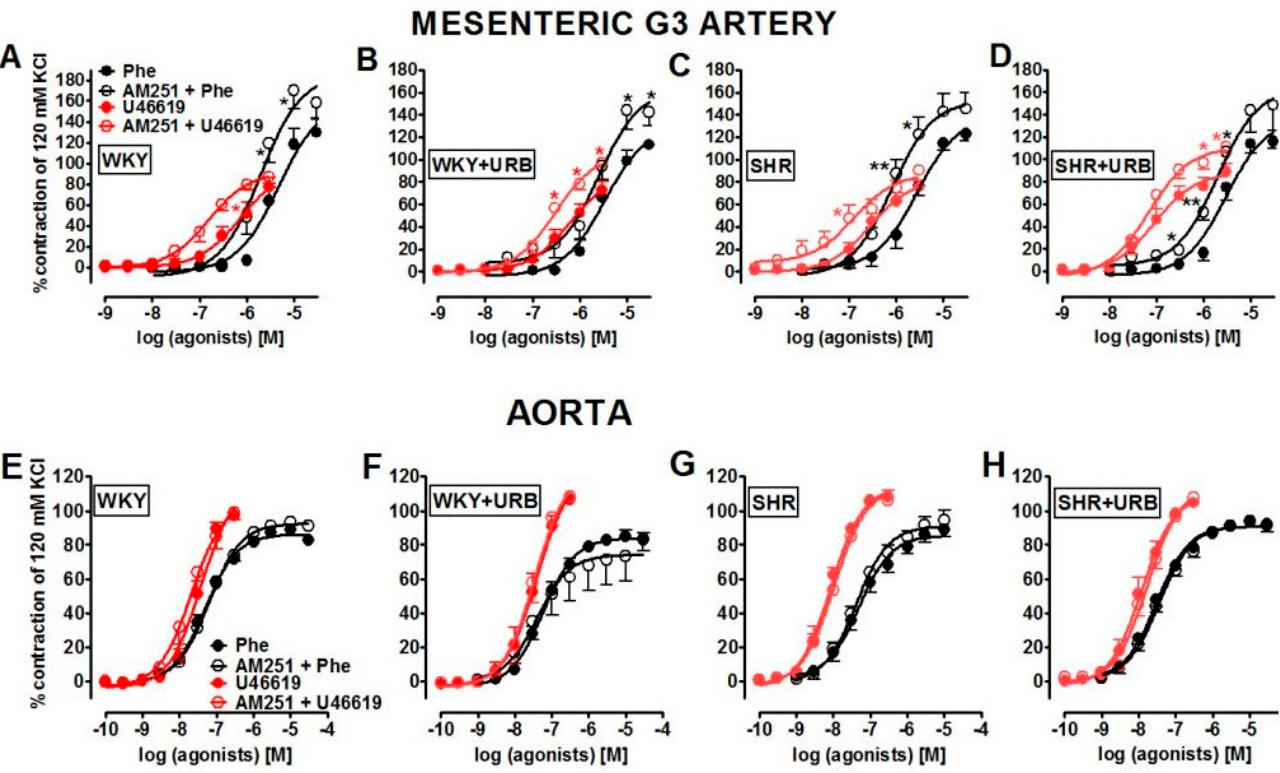
Figure 2. Influence of AM251 (1 µ M) on the vasoconstrictive effects of phenylephrine (Phe, black circles) and U46619 (red circles) in the mesenteric G3 arteries ( A – D ) and aorta ( E – H ) from normotensive control (WKY; A , E ) and URB597-treated (WKY + URB; B, F) rats, or hypertensive (SHR; C , G ) and URB597-treated (SHR + URB; D , H ) rats. URB597 at 1 mg/kg or its vehicle was injected intraperitoneally every 12 h for 14 days. Contractile responses are shown as percentages of the reference response to KCl. Mean ± SEM of n = 6–7 tissues for each curve. * p < 0.05 and ** p < 0.01 compared to the * WKY, as determined by Student’s t- tests for unpaired data. In a few cases, the SEM is smaller than or equal to the size of the symbols. See Tables 1 and 2 for statistical analysis .